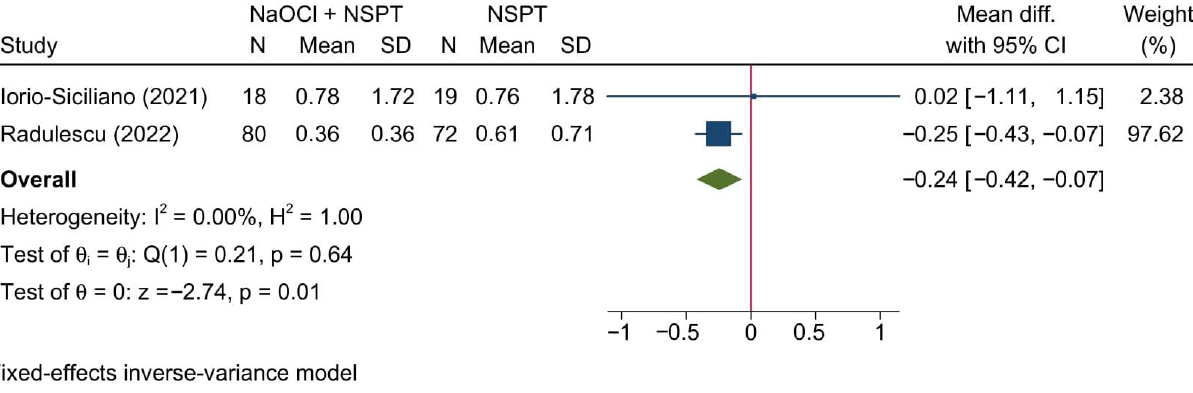
Figure 14. Forest plot showing the comparison between NaOCl + NSPT and NSPT alone regarding gingival recession [41,45].